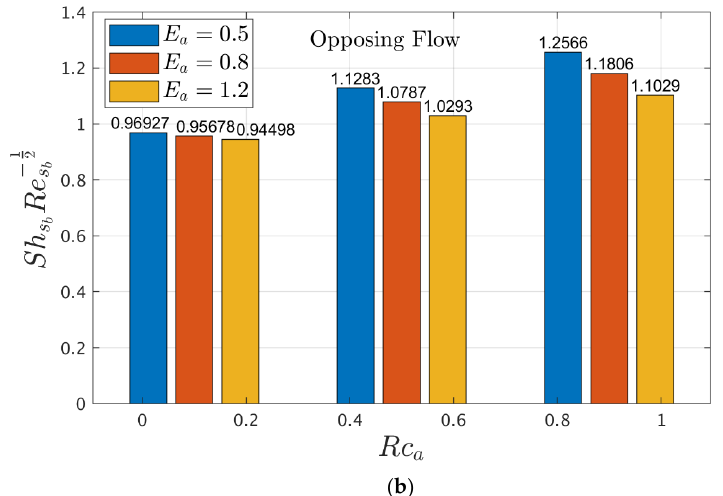
Figure 14. The bar graph represents the mass transfer against Rc a for the case of ( a ) assisting flow and ( b ) opposing flow with various values of the activation parameter.